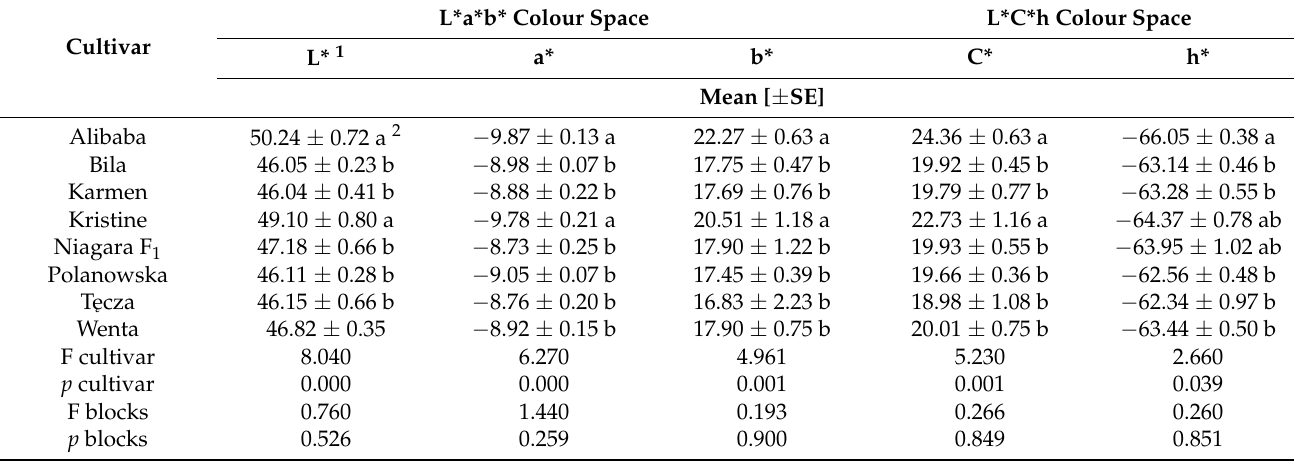
Table 2. Colorimetric characteristics of onion leaves in